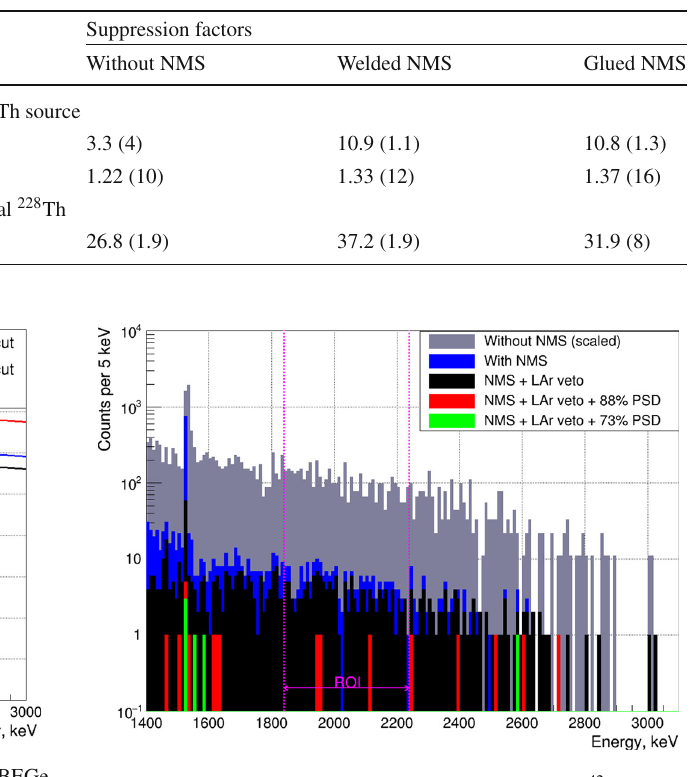
Fig. 13 A/E parameter versus the event energy registered by the BEGe Fig. 14 Energy spectra demonstrating the suppression of 42 Ar events detector in LArGe with NMS. Red dots indicate events removed by by the NMS and combined PSD and LAr coincidence with the LAr veto. Both 42 Ar sources were used Table 5 Number of counts from the 42 K measurement, before and after applying LAr veto and PSD cuts for the BEGe detector with the NMS Energy regions (keV)